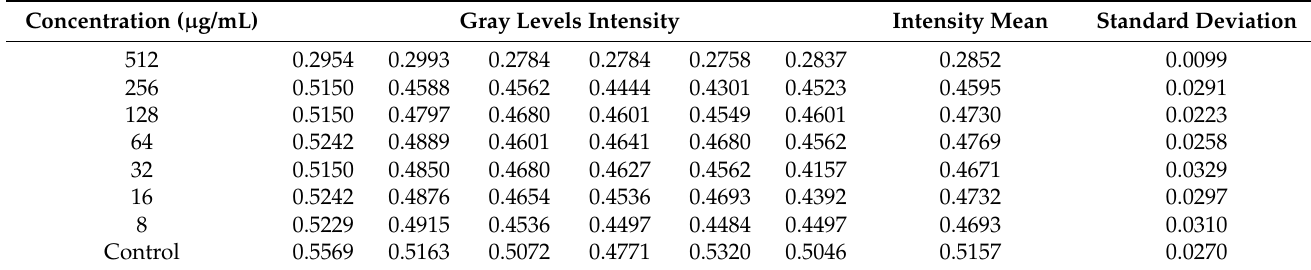
Table 3. The 1199B strain—Gray levels intensity before the addition of resazurin. Gray Levels Intensity Intensity Mean Standard Deviation